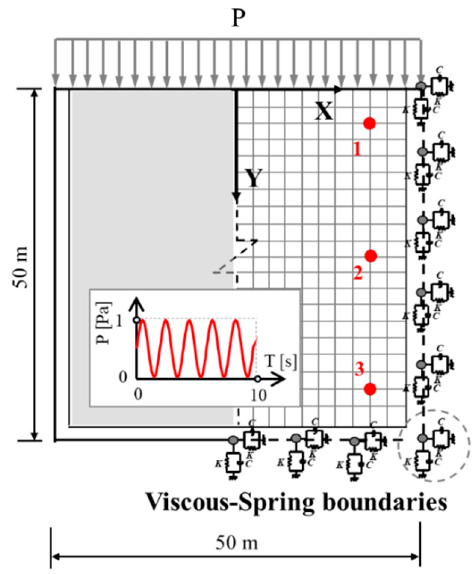
Figure 5. Numerical model for 2D saturated porous media.